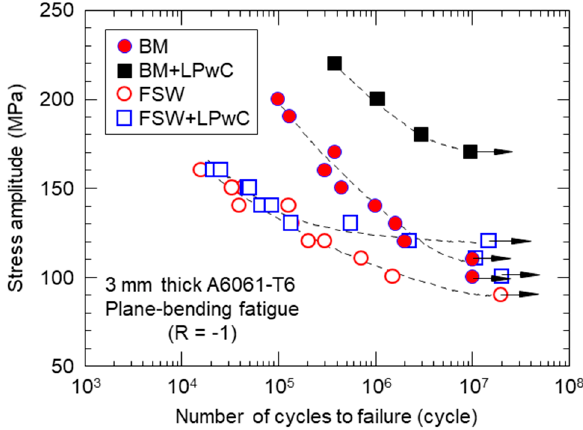
Figure 7. S-N curves of the A6061-T6 base material (BM), the friction stir welded material (FSW), and both materials after LPwC. The fatigue strength of the FSWed material was enhanced by LPwC to beyond that of the BM.